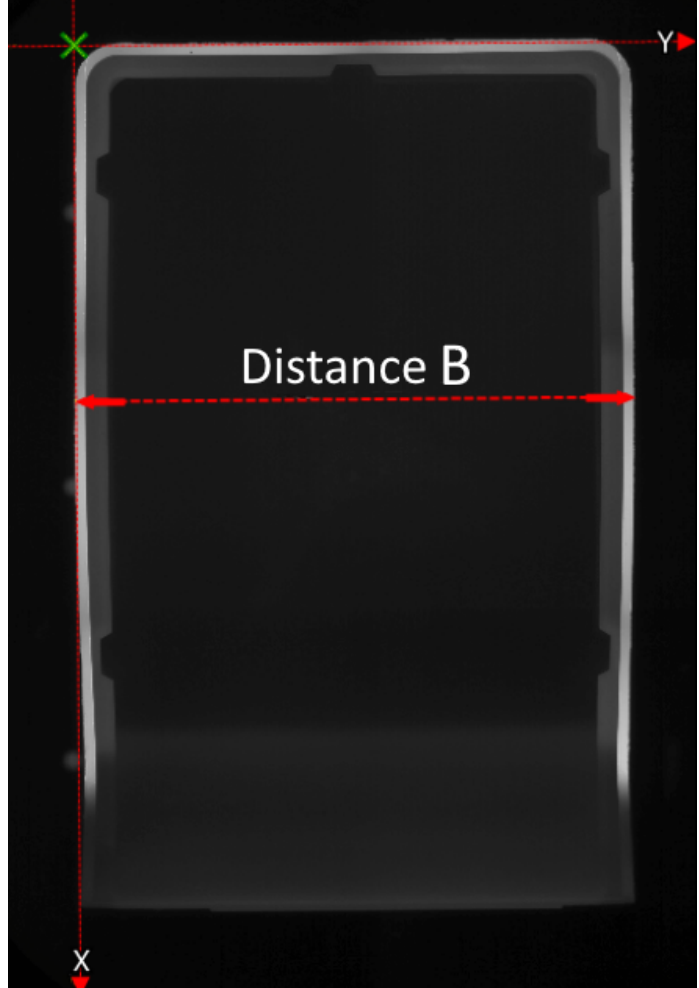
Figure 6. Geometrical measurement at X = 25mm (top